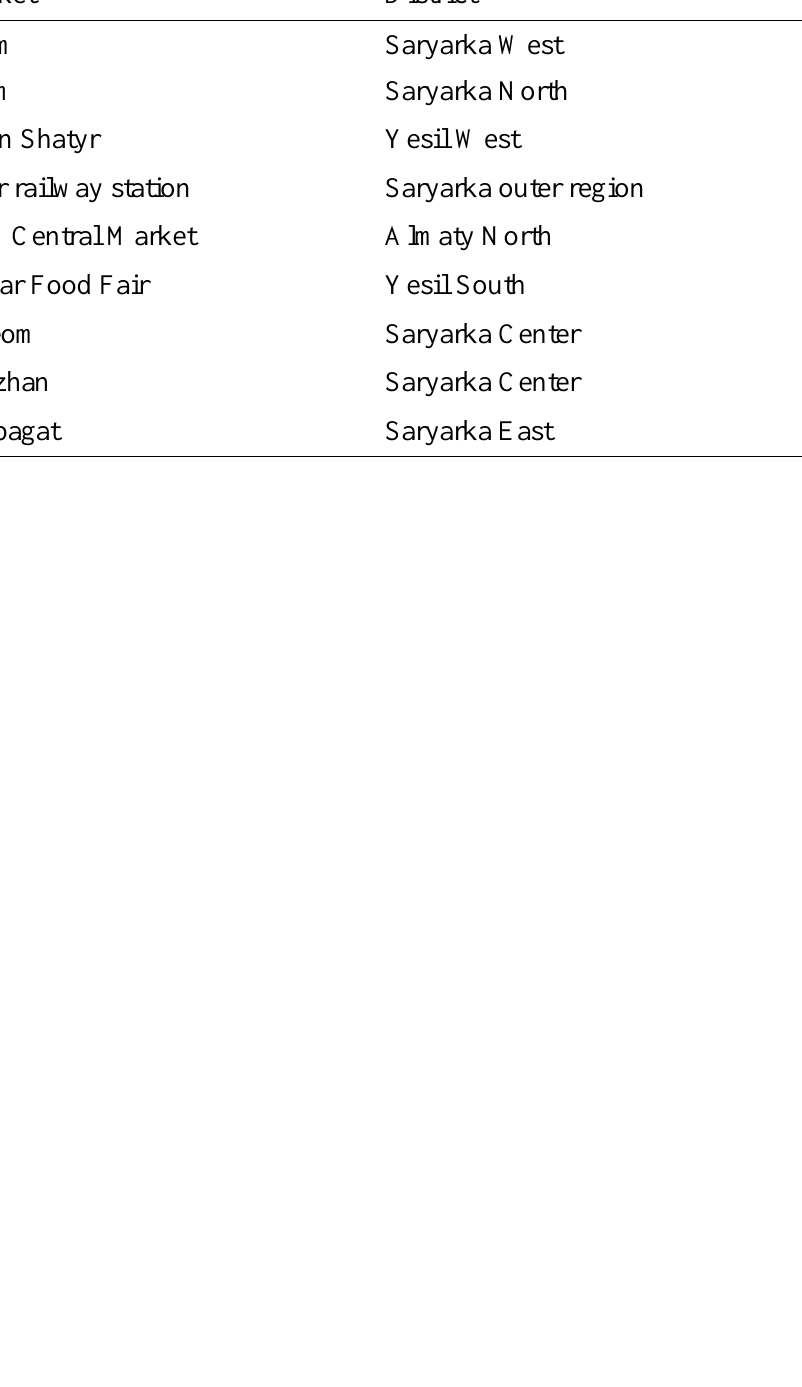
Table 1: Marketplaces in Astana by district